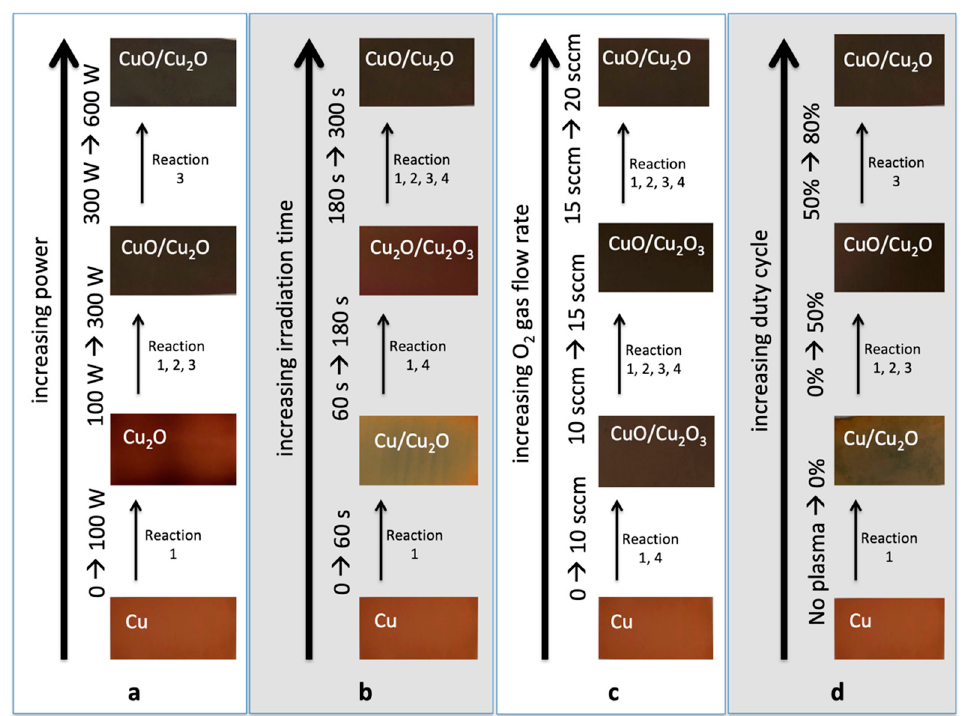
Figure 8. Mechanism of CuO, Cu 2 O, and Cu 2 O 3 formations from the plasma surface modification of Cu, with increasing: ( a ) power; ( b ) irradiation time; ( c ) O 2 gas flow rate; and ( d ) duty cycle. The images of the actual samples can also be seen with the corresponding chemical elements and compounds.